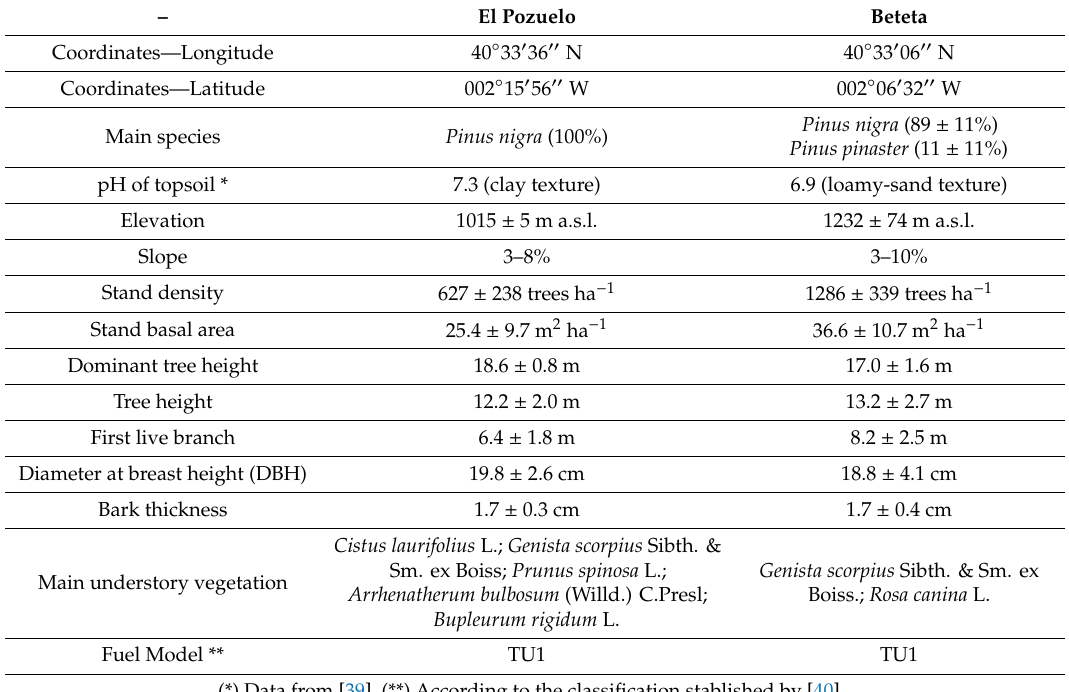
Table 1. Main characteristics of El Pozuelo and Beteta (mean and standard deviation).